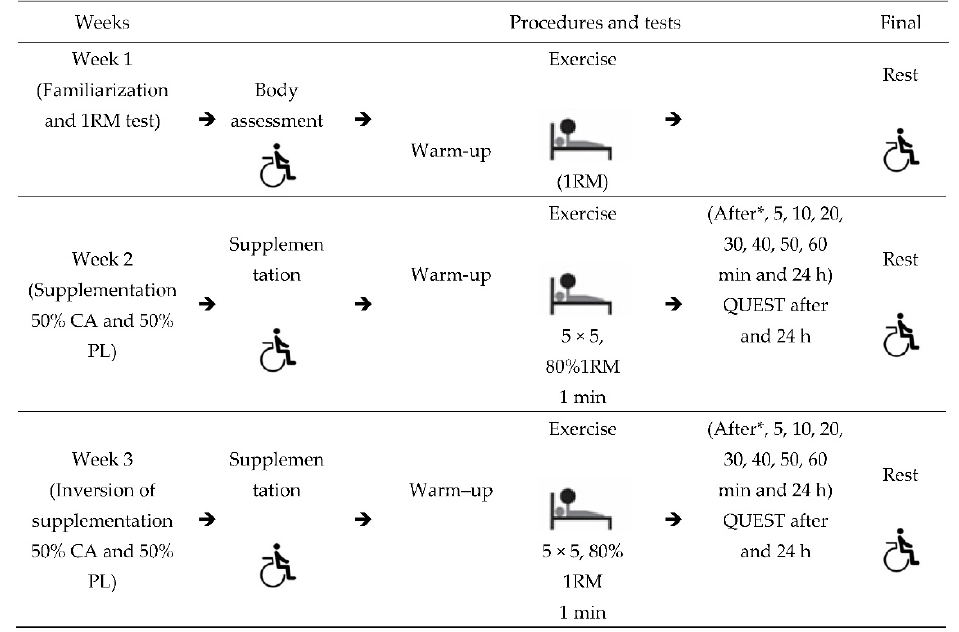
Figure 1. Experimental study design. * Immediately after; 5 × 5: five sets of five repetitions; 1RM: One repetition maximum; Rest: return to daily activities; QUEST: side effects questionnaire; 1 min: 1 min break between blocks.